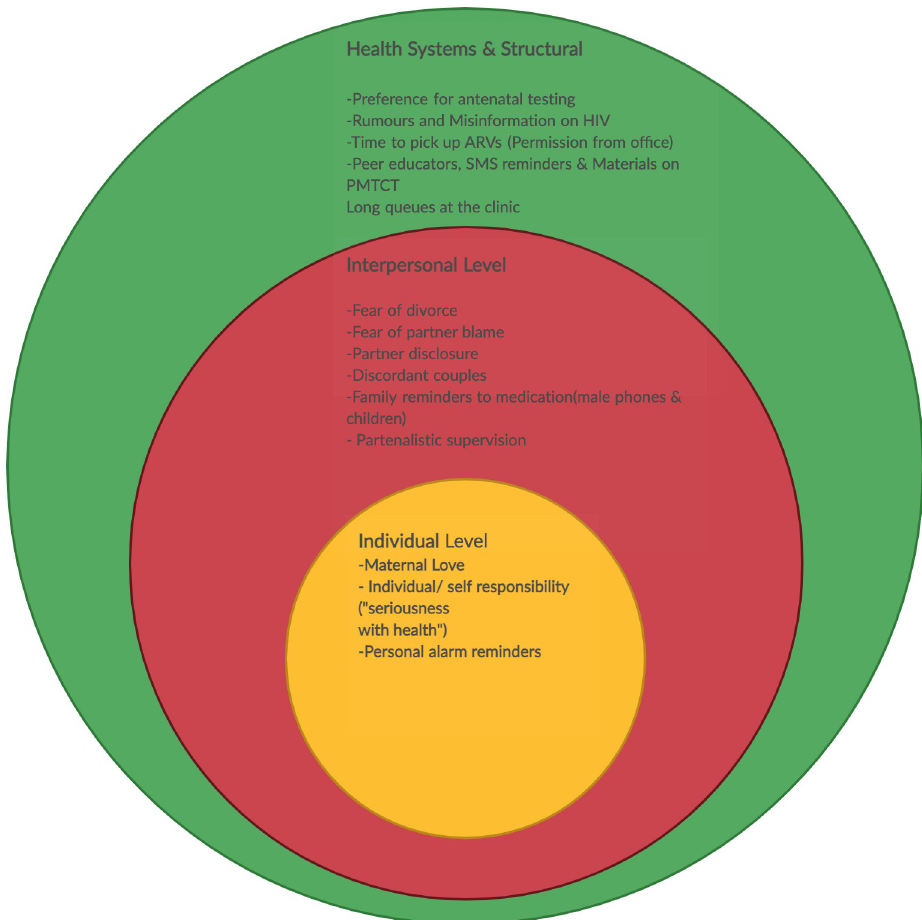
Fig 1. Social ecological framework on barriers & facilitators to initiation and adherence among women and men. Source: Adapted and developed by the authors.